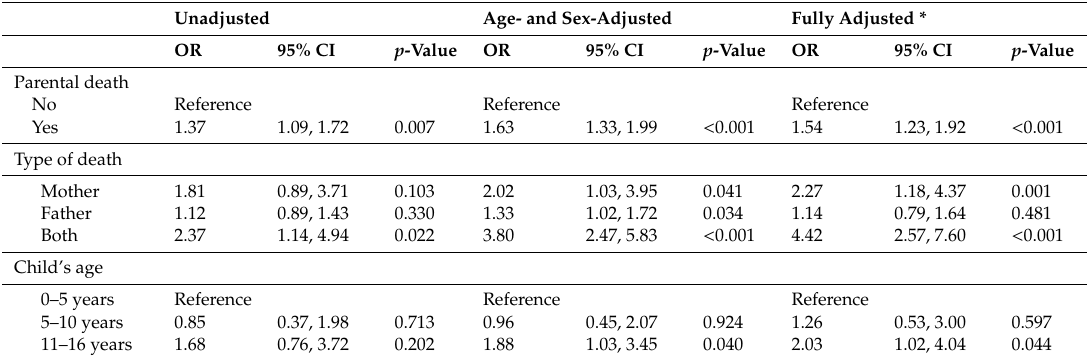
Table 2. Associations between early parental death and psychosis in the EU-GEI case-control sample.